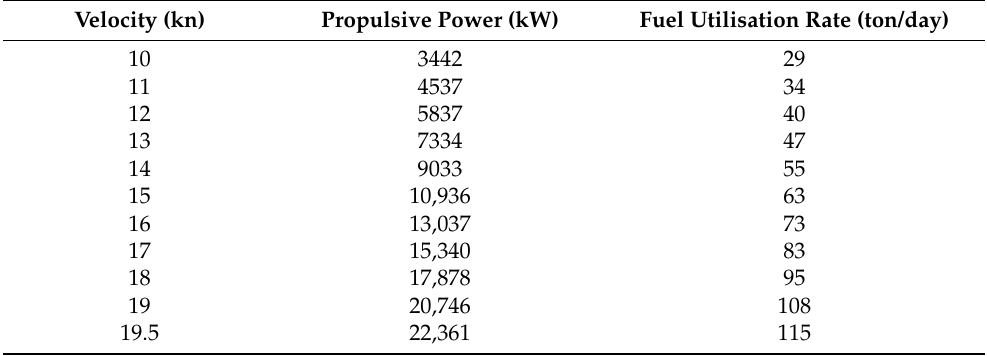
Table A2. Power and fuel utilisation rates of the conventional LNG ship at velocities of 10 to 19.5 kn